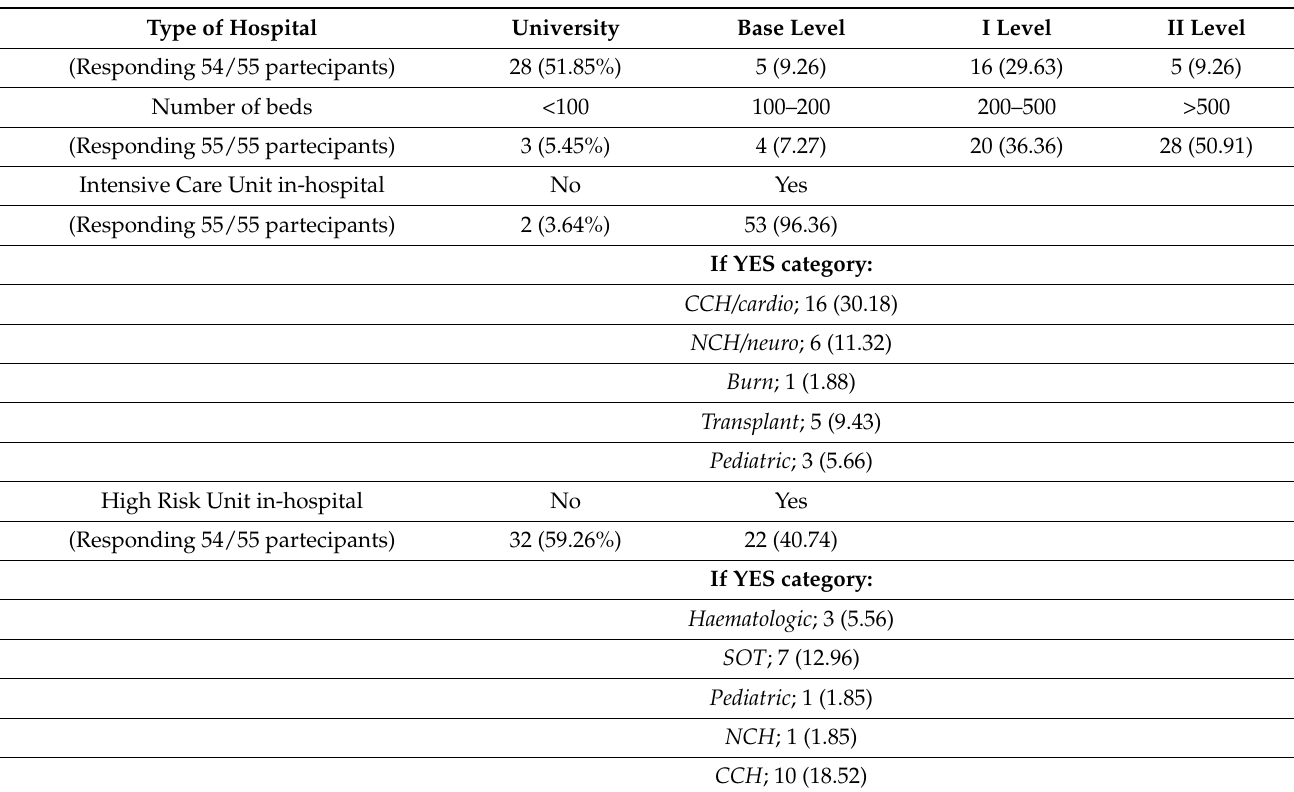
Table 1. Features of the centers enrolled in the survey.